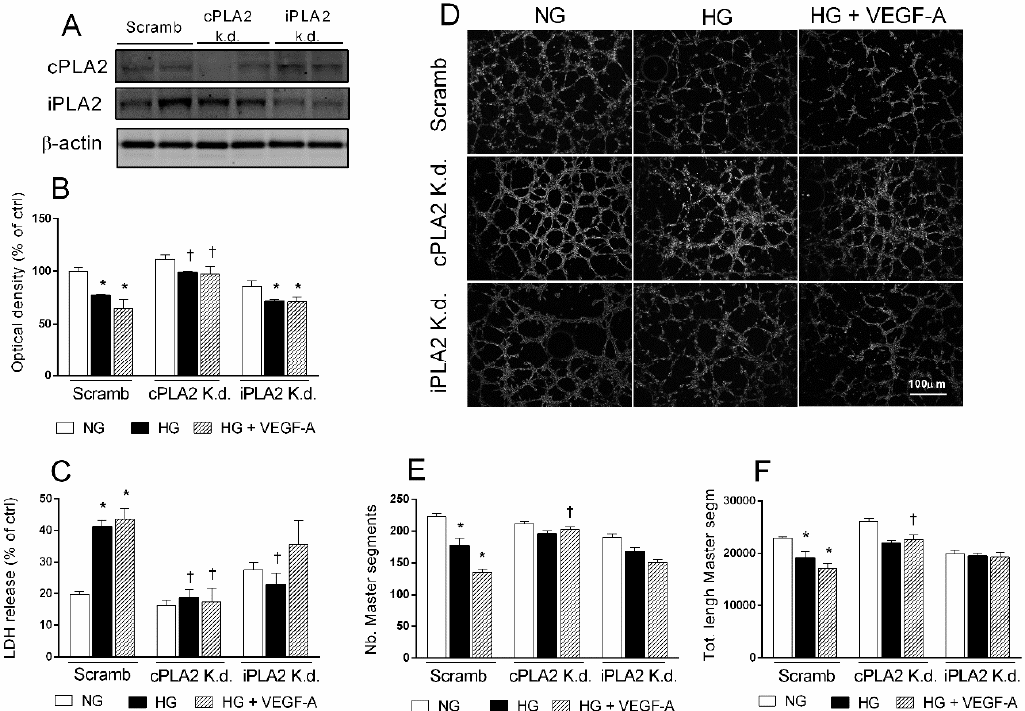
Figure 6. Effect of PLA2 silencing on detrimental effects of high glucose (HG) in human retinal endothelial cells (HRECs). Cell lysates of HRECs transfected with siRNA against cPLA2 (cPLA2 K.d.), iPLA2 (iPLA2 K.d.), and scrambled siRNA (Scramb) were analyzed by Western blot 48 h after transfection using antibodies against total cPLA2 and iPLA2 to evaluate efficiency of knockdown. Western blot analysis of lysates from two randomly selected independent transfections are shown in panel ( A ). Immunoblotting of β -actin was used to assess equal loading (30 µg of protein per lane). Transfected HRECs were incubated with normal glucose (5 mM, NG), high glucose (25 mM HG), or HG plus VEGF-A (80 ng/mL) for 48 h and analyzed in MTT assay (panel B ) or LDH release assay (panel C ). Transfected cells were also seeded into 96-well plate coated with matrigel at a density of 1.5 × 10 4 and incubated as described above. After 16 h, tube like-structures were photographed (panel D ) and images were analyzed for total number (panel E ) and length (panel F ) of tube-like structures with Image J software. Values are expressed as a mean ± SEM of three independent experiments, each run in triplicate. * p < 0.05 vs. scrambled NG; † p < 0.05 vs. scramb HG or scramb HG plus VEGF-A. One-way ANOVA, followed by Tukey’s test.